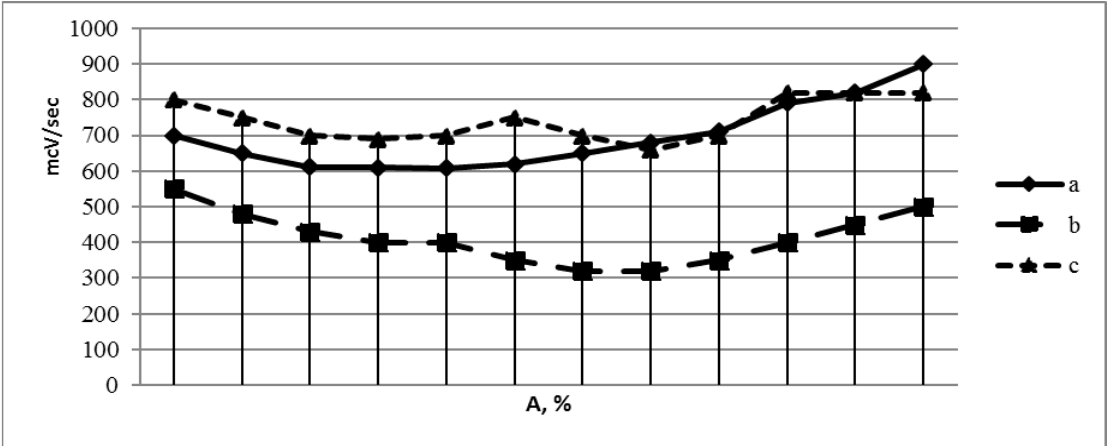
Fig. 4. Changes of integrated electrical activity of muscles (mcV/sec) of elite cyclists in trainings of speed power ( a ), anaerobic ( b ) and aerobic ( c ) orientation. A – Period of